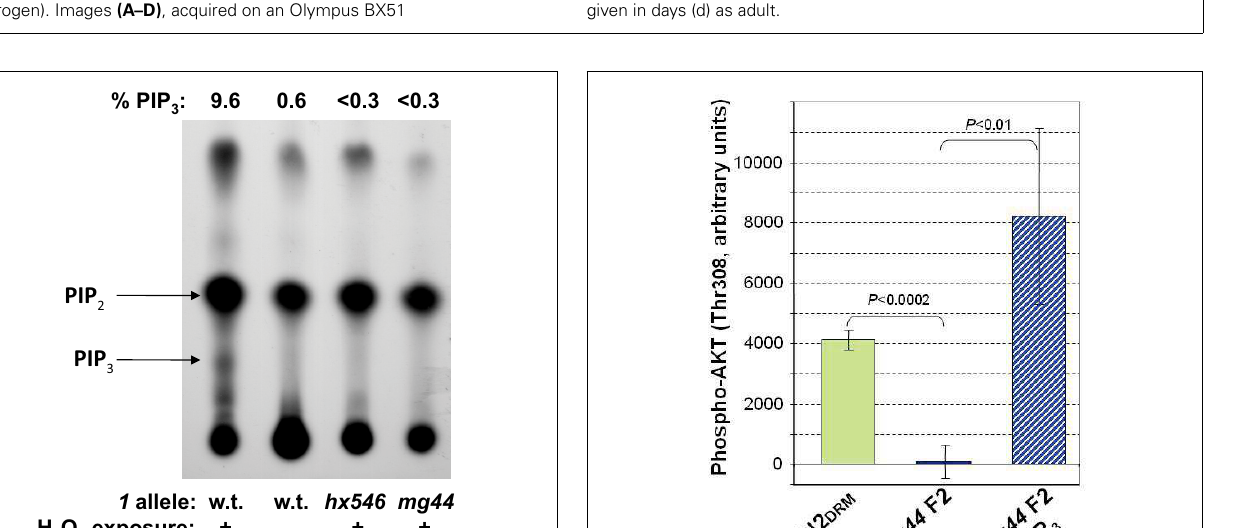
microscope, were quantified with ImageJ and summarized in (E) for a typical experiment. Histogram bars show means ± SEMs for 20–50 worms per group. Background, assessed without primary antibody, is shown (rightmost bar) but has not been subtracted.Worm ages are given in days (d) as adult.